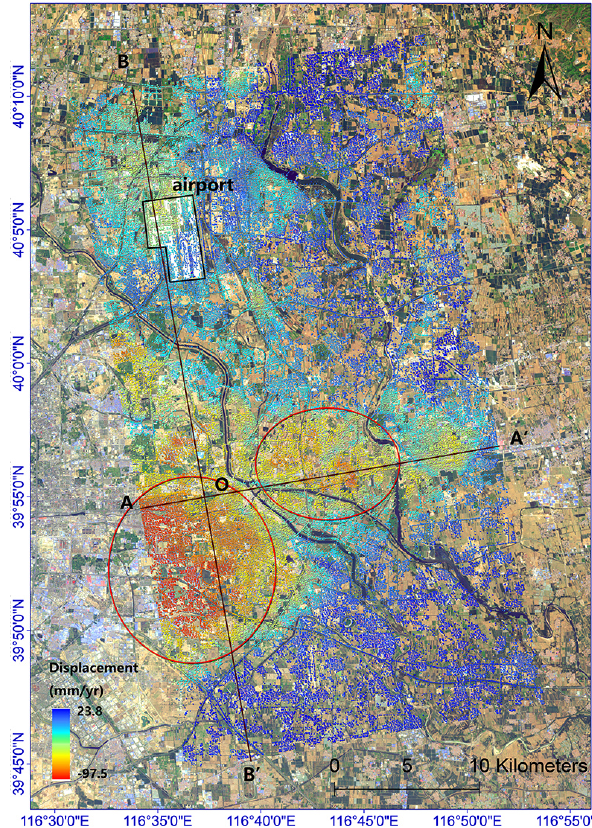
Figure 2. Mean LOS subsidence rates (mmyr − 1 ) spatial distribu- tion. Red and blue areas represent subsidence and uplift relative to the referenced point M1, respectively. Profile A–A (cid:48) , which is per- pendicular to profile B–B (cid:48) , goes through the two subsidence areas (marked as red circles), and intersects the profile B–B (cid:48) at O. The black box represents the location of Beijing Capital International